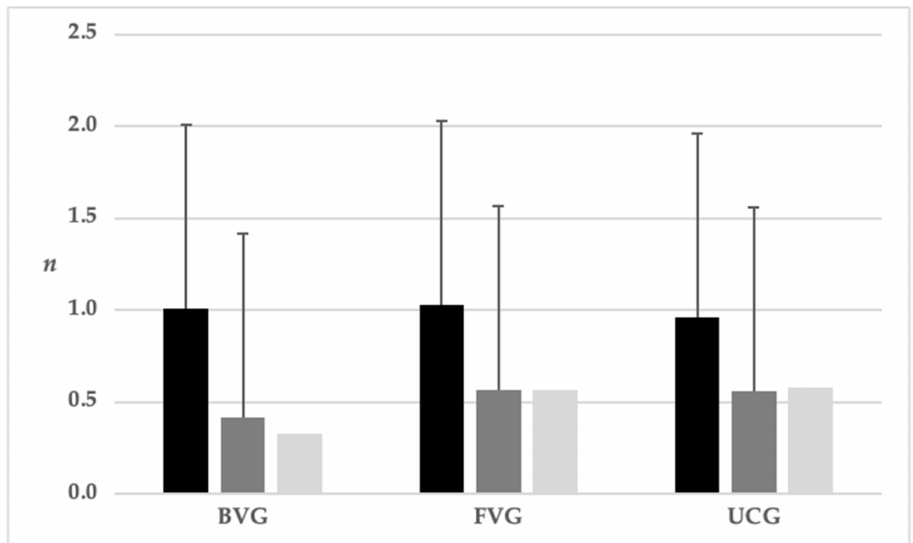
Figure 2. Means and standard deviation of total contacts (black) and infected contacts related to the total number per infected persons (dark grey; median light grey) in the booster-vaccinated group (BVG) vs. fully vaccinated group (FVG) vs. unvaccinated control group (UCG; p -values see Table 1). Table 2. Pairwise comparison of total infected contacts related to the total number per infected persons between BVG (booster-vaccinated group) vs. FVG (fully vaccinated group) vs. UCG (unvaccinated control group). Sample p -Value * p -Value after Bonferroni Correction * BVG vs. UCG 0.008 0.025 BVG vs. FVG 0.002 0.005 UCG vs. FVG data